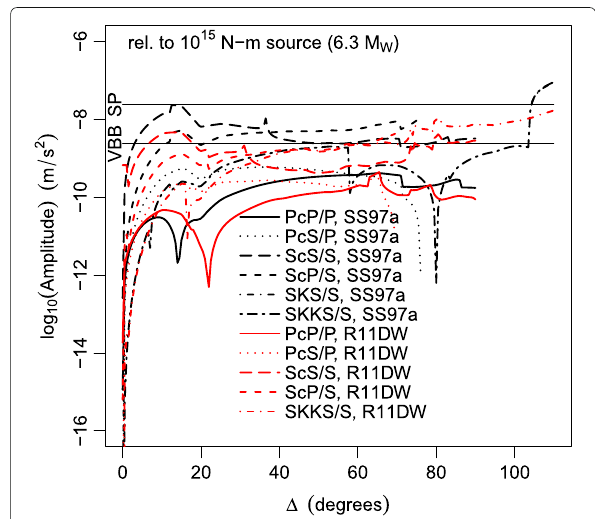
Fig. 9 Detection limits of selected core-related arrivals needed to determine core radius and outer core structure. Various curves show the expected acceleration levels expected for a 10 15 N-m source recorded at various ranges (in degrees of great circle arc) from the seismometer. The sensitivity levels of the InSight SP and VBB instruments are shown as horizontal lines (Lognonné et al. 2014). For methods used, see the “Appendix”